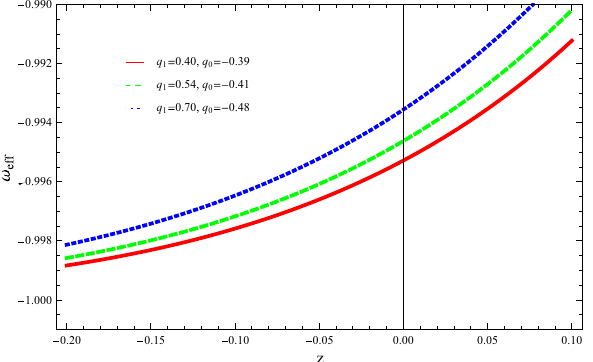
Fig. 12 Plotof S (cid:5)(cid:5) tot versus z atHubblehorizonwithBekensteinentropy